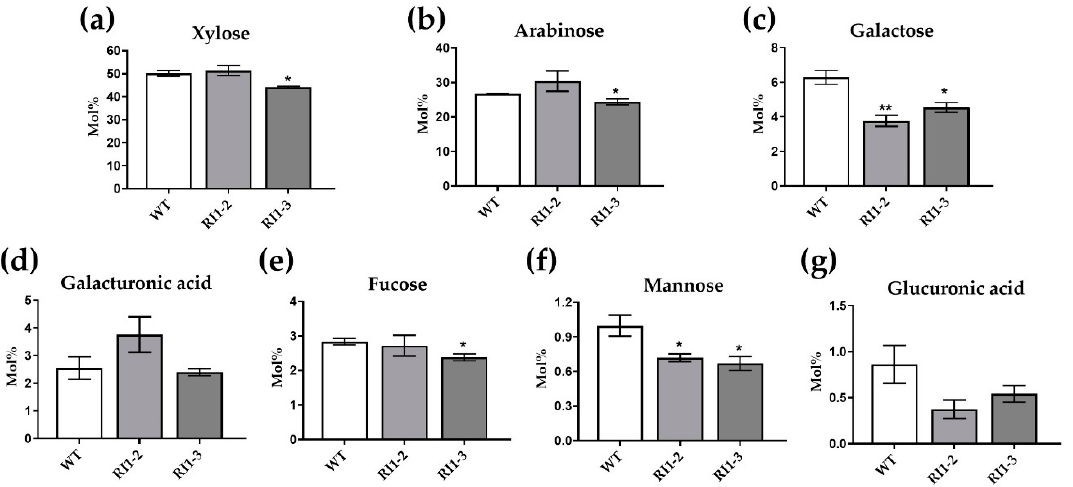
Figure 4. Cell wall monosaccharide composition (mol%) isolated from 3-week-old wild type (WT) and OsVTC1-1 RNAi lines. ( a ) xylose; ( b ) arabinose; ( c ) galactose; ( d ) galacturonic acid; ( e ) fucose; ( f ) mannose; ( g ) glucuronic acid. Bars represent the means and standard errors of three replicates. Asterisk indicates statistically significant differences between WT and OsVTC1-1 RNAi lines analyzed using Student’s t -test (* p < 0.05 and ** p < 0.01).